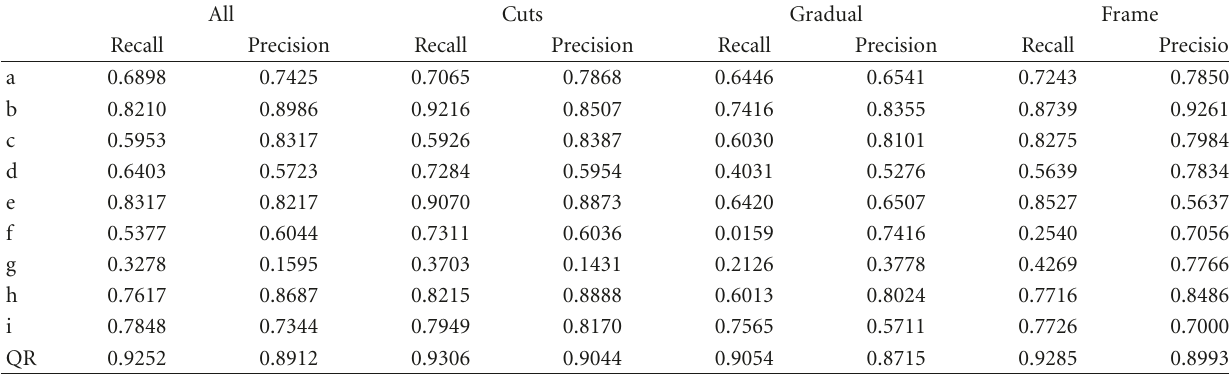
Table 3: The results of experiments on TRECVID 2006 data set.